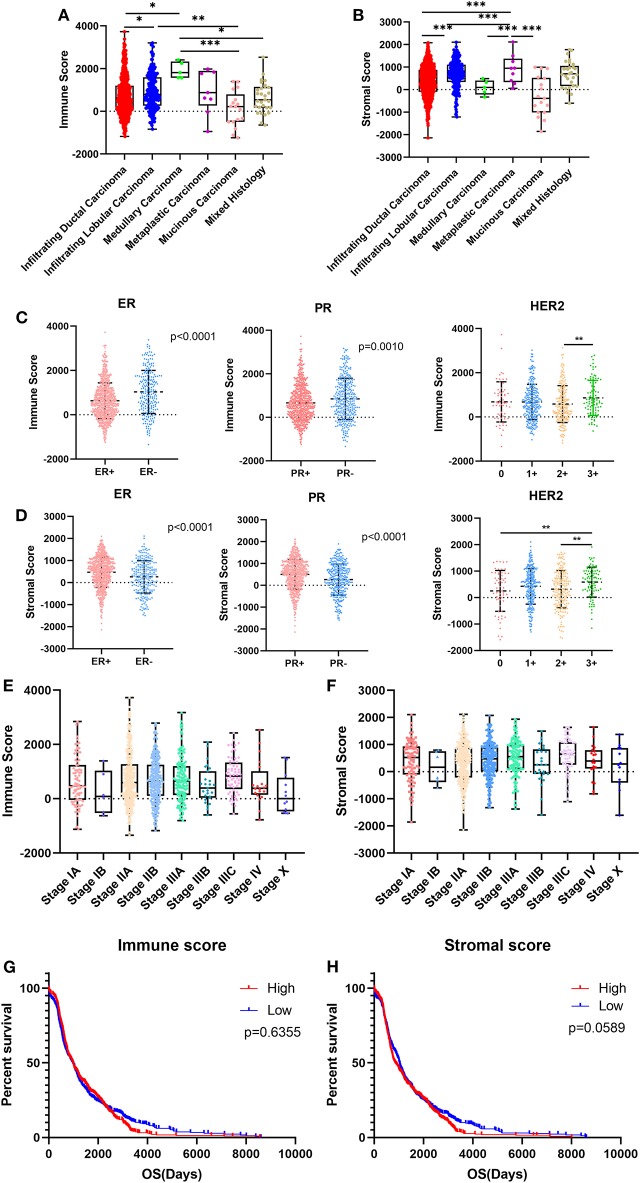
Immune scores and stromal scores are associated with breast cancer subtypes and patient overall survival. (A,B) Distribution of immune scores or stromal scores among breast cancer pathological subtypes. (C,D) Distribution of immune scores or stromal scores among breast cancer molecular subtypes. (E,F) Distribution of immune scores or stromal scores among breast cancer stages. (G,H) Patients were divided into high- and low-score groups according to their immune scores or stromal scores. Kaplan-Meier plots were generated to compare overall survival (days) in the high- and low-score groups. Differences were assessed with a log-rank test. *p < 0.05, **p < 0.01, and ***p < 0.001 for analysis of variance (ANOVA).